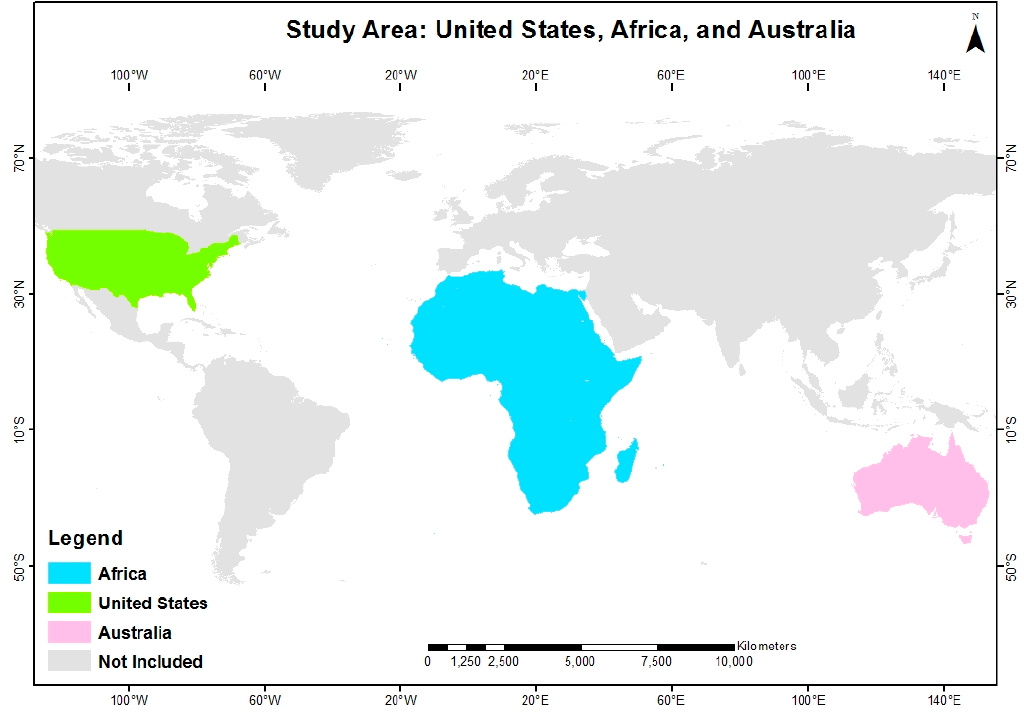
Figure 1. Map showing the location of three selected continents and their respective homogeneous regions such as agro-ecological zones (AEZs) and crop buffer.